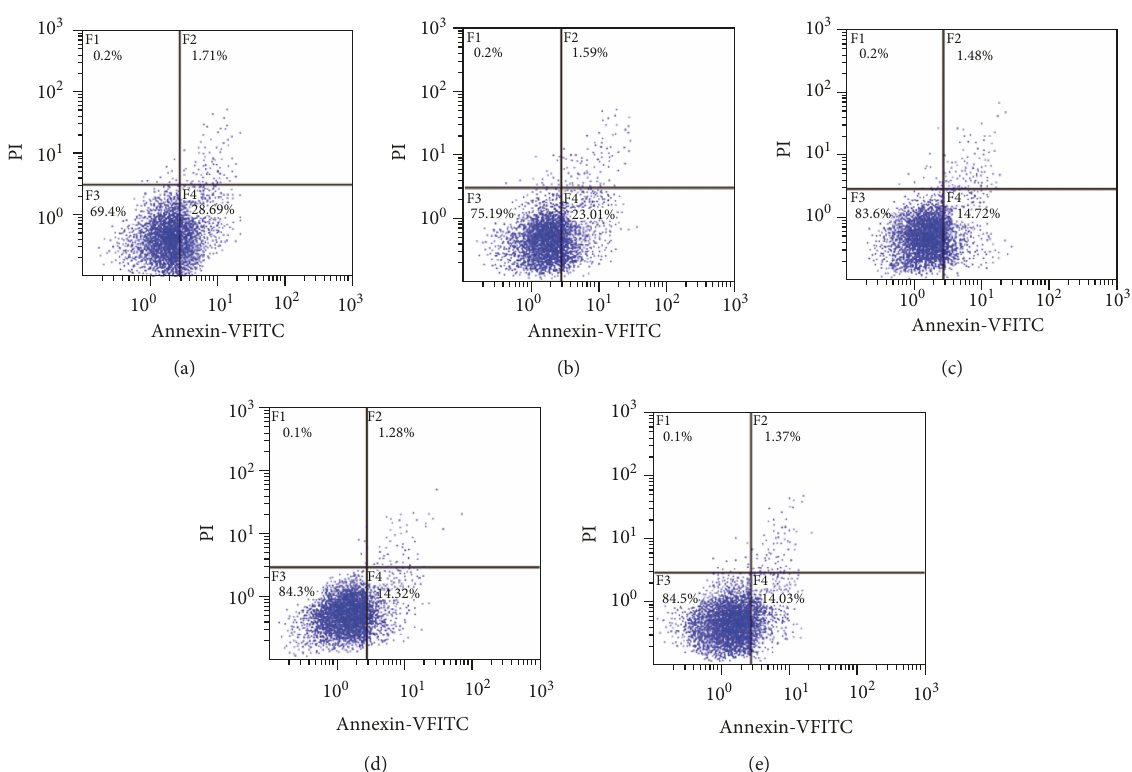
Figure 3: Flow cytometry was used to detect the e ff ect of PSP on apoptosis induced by 200 μ M H 30.4%. (b) Apoptosis rate (24.6%) under the treatment of 0.625 mg/L PSP. (c) Apoptosis rate (16.2%) under the treatment of 1.250 mg/L PSP. (d) Apoptosis rate (15.4%) under the treatment of 2.5mg/L PSP. (e) Apoptosis rate (15.6%) under the treatment of 5mg/L PSP.